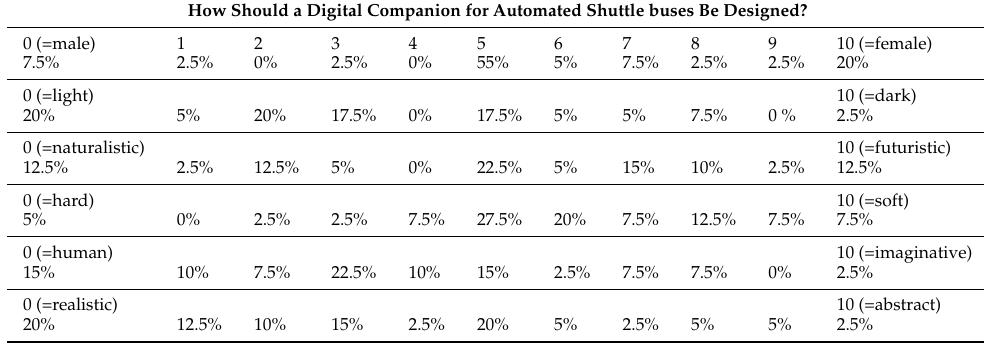
Table 4. Descriptive Statistics: Characteristics of Digital